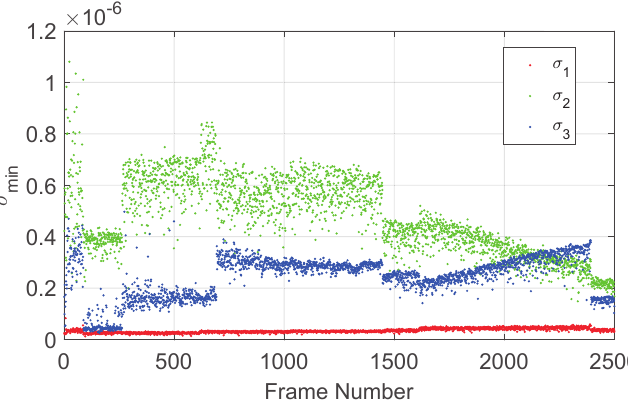
Figure 4. Observability analysis of the three singular values.